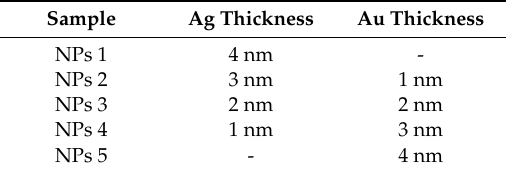
Figure 1. Schematic illustrations of the sample preparation process. ( a ) Double-metallic nanoparticles (NPs) on an undoped GaN (u-GaN) layer for measuring the resonant frequency of localized surface plasmon (LSP) modes. ( b ) Double-metallic NPs on a green light-emitting diode (LED) for measuring the enhancement factor (EF) of the photoluminescence (PL) intensity. Table 1. Thicknesses of Au / Ag multilayers to form the double-metallic